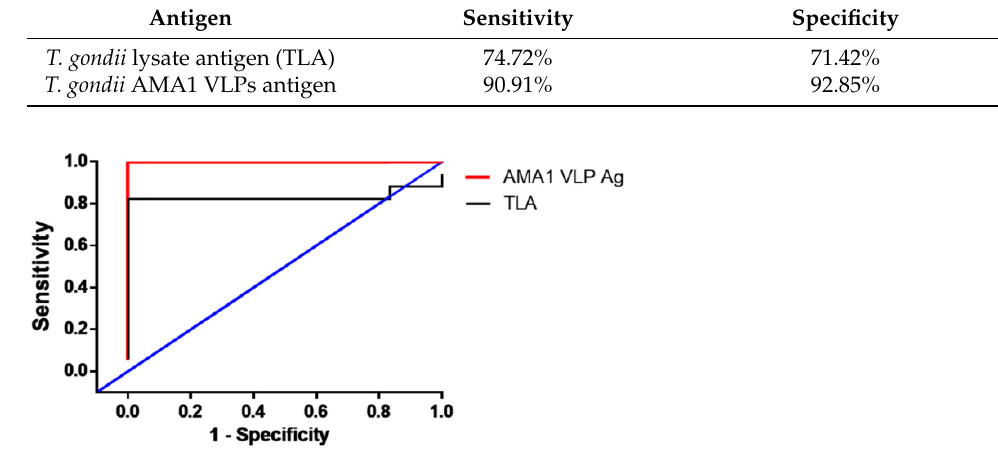
Figure 8. Comparison of receiver operating characteristics (ROC) curves. ROC analysis was used to compare the sensitivity and specificity of ELISA data acquired from AMA1 VLPs and TLA. The blue line shows a non-informative test curve.